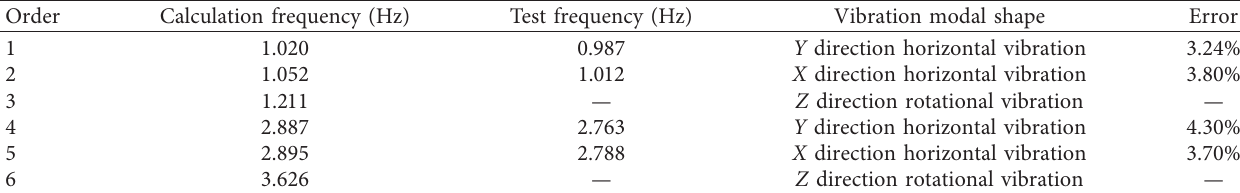
Table 4: Natural frequencies of structure from numerical results and test